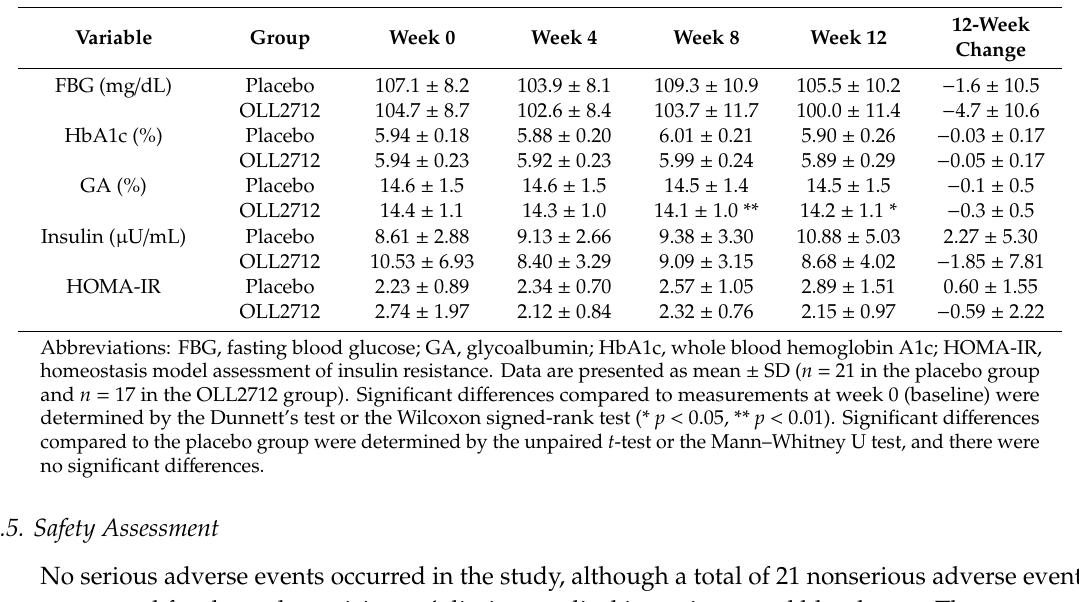
Table 6. Subgroup analysis in the participants whose HOMA-IR levels were more than 1.6 at week 0